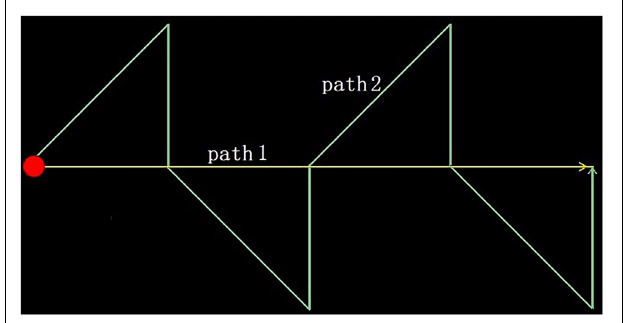
FIGURE 2 | The moving trajectories of the light spots in the two experimental schemes.